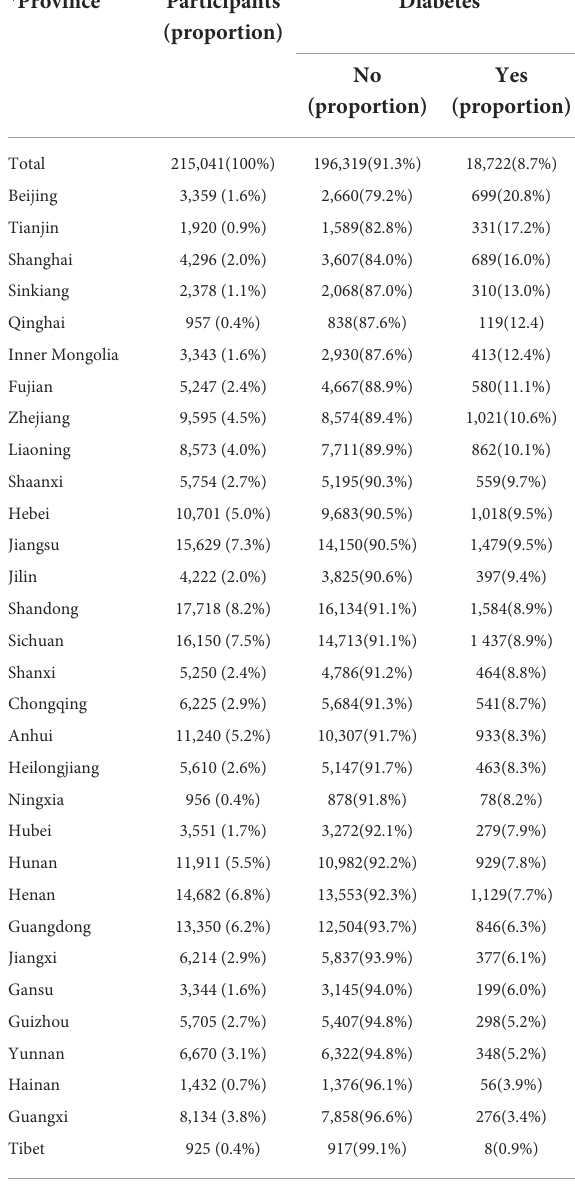
TABLE 1 The prevalence of diabetes in the elderly of